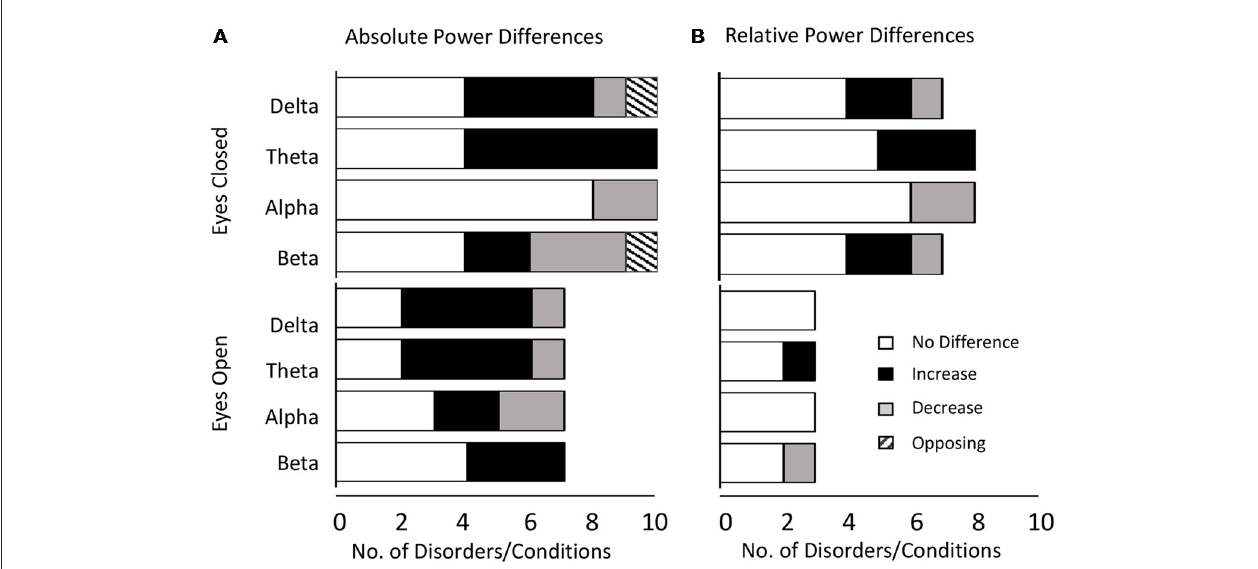
FIGURE 2 | Dominant result aggregated across all disorders and bands. (A) Number of disorders with no difference in absolute power relative to controls (white), an increase (black), a decrease (gray) or opposing results (hashed) for eyes closed (top) and eyes open (bottom) conditions. Increases are more common for lower frequency bands (delta and theta) whilst decreases or no significant difference are more common for higher frequency bands (alpha and beta). (B) Same as (A) for relative power. Legends and axis labels are common.